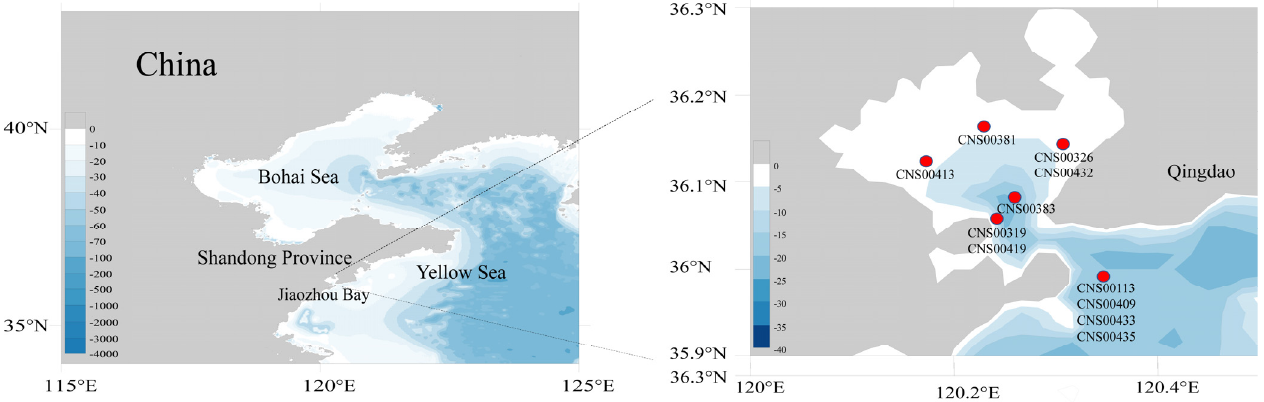
Figure 1. Sampling sites of 11 diatom species in Jiaozhou Bay.